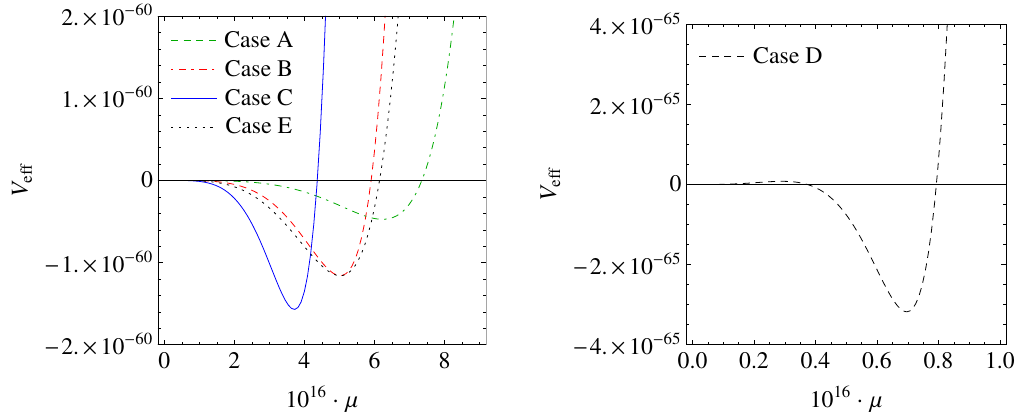
Figure 2 . The e(cid:11)ective potential as a function of (cid:22) , in units of ‘ , in scenarios A 1 , B 8 , C 2 , E 1 (left panel) and D 1 (right